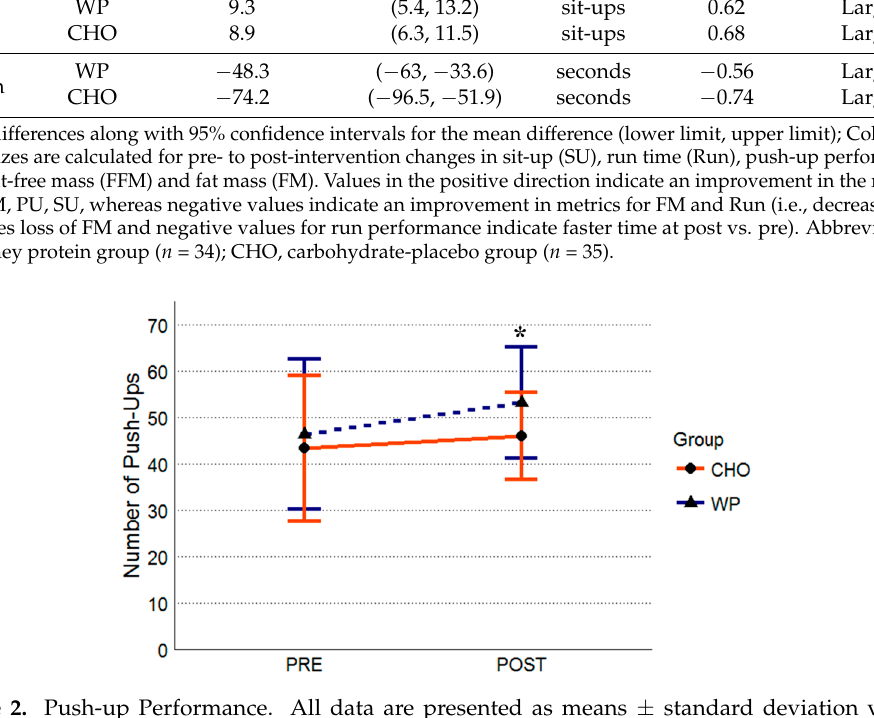
Figure 2. Push-up Performance. All data are presented as means ± standard deviation values. Abbreviations: WP, whey protein group ( n = 34); CHO, carbohydrate-placebo group ( n = 35). Symbols: *, indicates WP > CHO at POST.